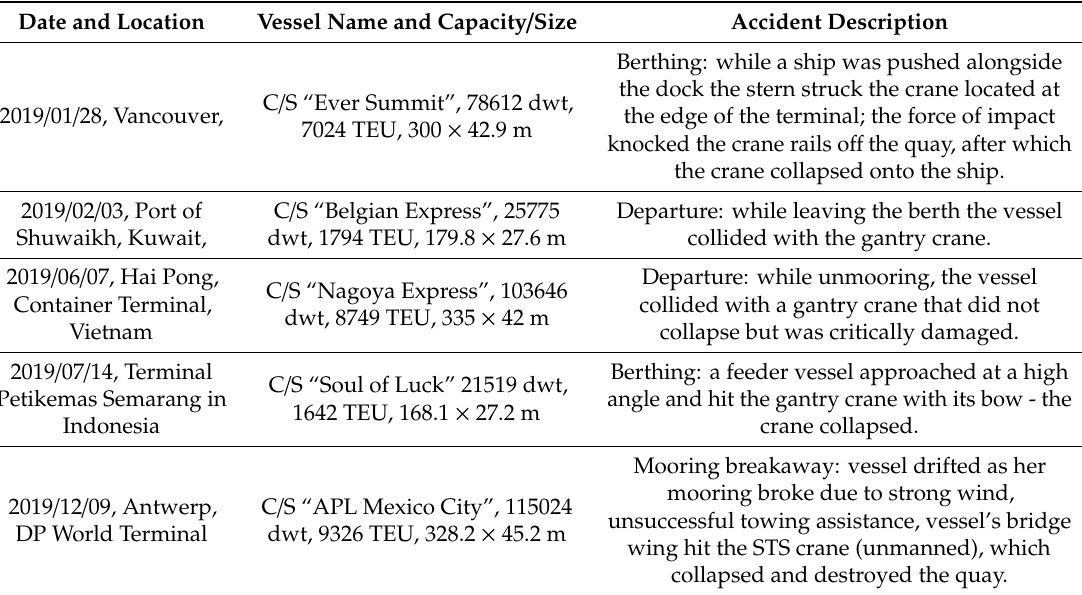
Table 1. Container ship/crane accidents in 2019 .